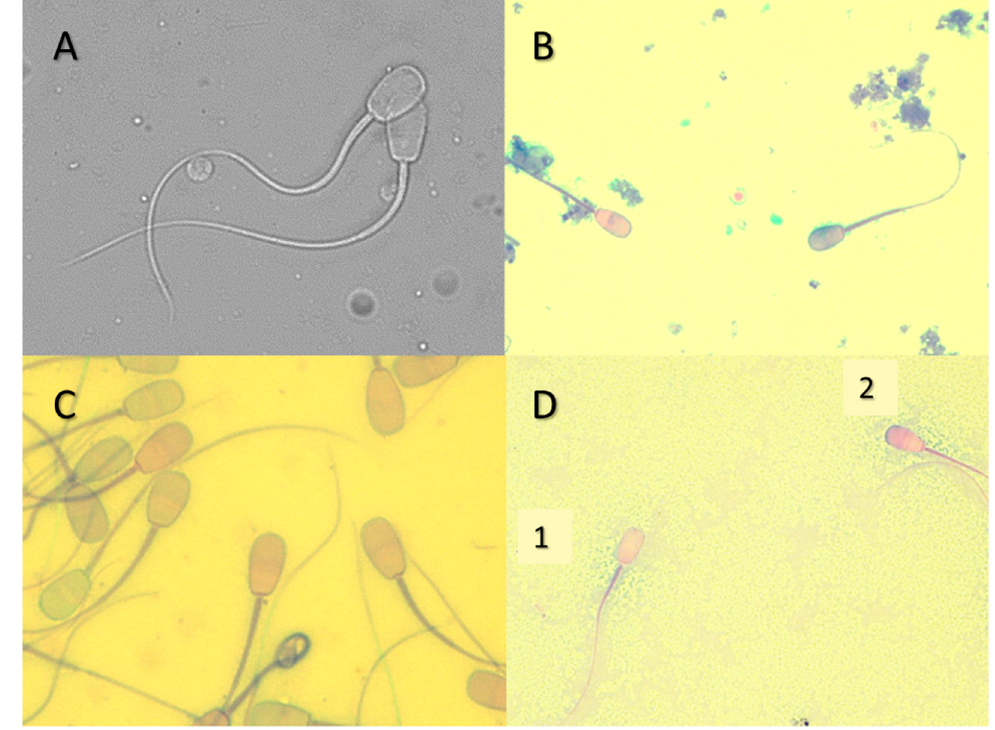
Figure 2. Spermatozoa from M. americana . ( A ) Spermatozoa in phase contrast to evaluate sperm morphology, ( B – D ) spermatozoa with simple acrosome dye to analyze their integrity, ( D1 ) injured acrosome, and ( D2 ) intact acrosome.